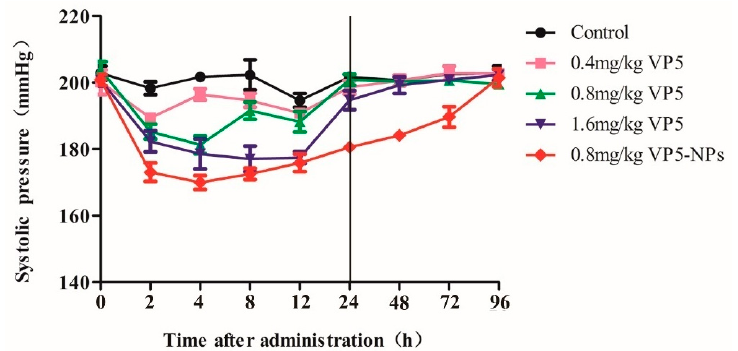
Figure 4. Antihypertensive effects of different doses of VP5 and VP5-NPs in SHRs within 96 h by a single oral administration. Table 1. The decreasing amplitude of systolic blood pressure of spontaneously hypertensive rats (SHRs) at different time points after a single oral dose (X ± SD, n = 6) (mmHg).